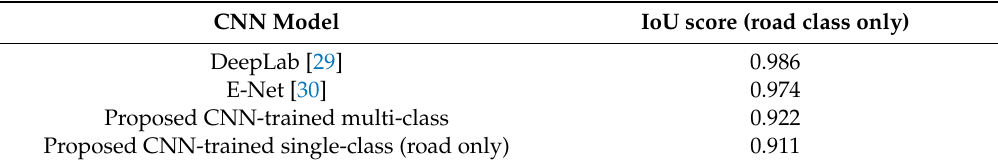
Table 1. Evaluating segmentation with state-of-the-art, using the Intersect Over Union (IoU) performance